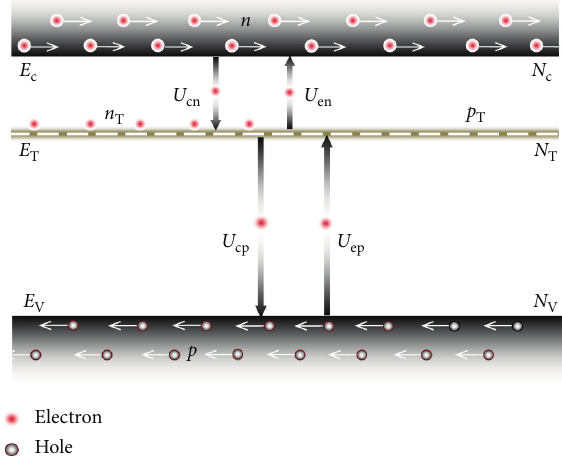
Figure 1: Energy band structure with a localized